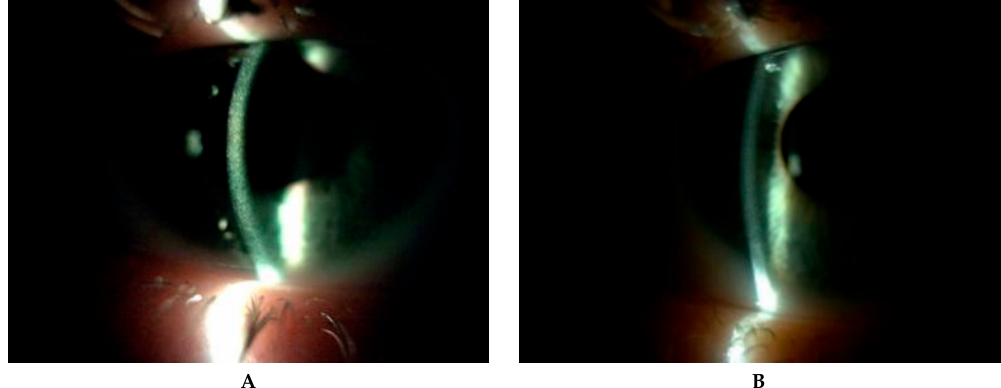
Figure 6. Corneal cystine crystals in slit lamp (10 × ) before administration of hospital formulated 0.5% cysteamine ( A ) and one year after application of 0.55% Cystadrops ( B ) in patient 2.